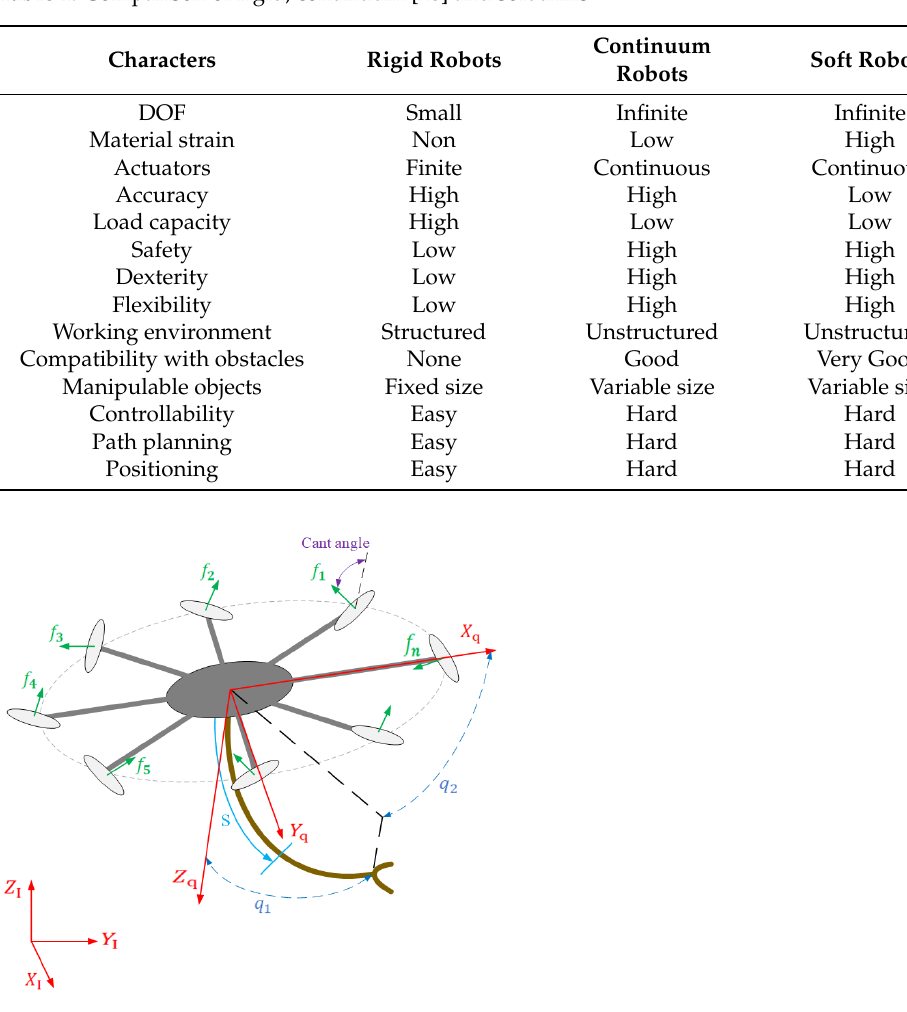
Table 1. Comparison of rigid, continuum [20] and soft arms.